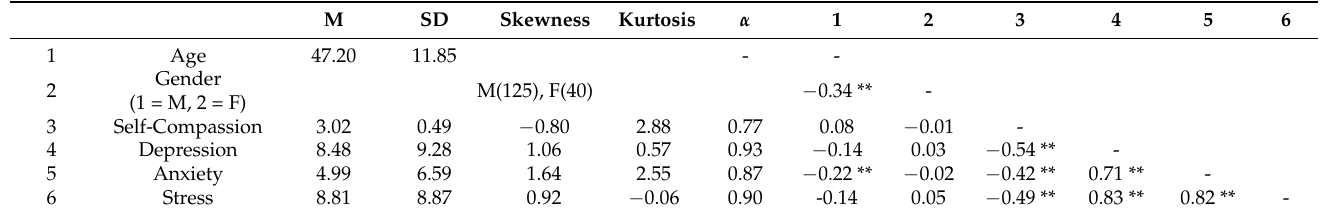
Table 1. Correlations among self-compassion, depression, anxiety and stress in Japanese workers.